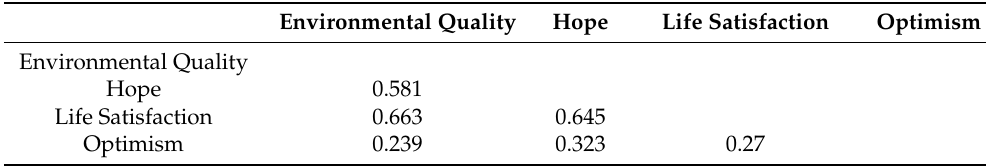
Table 3. Discriminant validity through HTMT 0.85 .